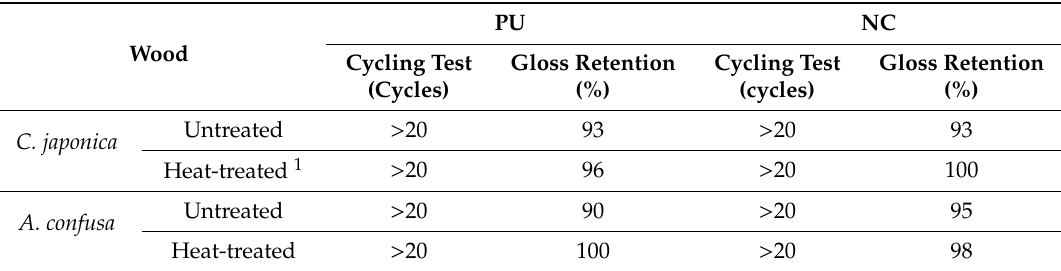
Table 3. Cycling test and gloss retention of untreated and heat-treated Japanese cedar ( Cryptomeria japonica ) and Formosa acacia ( Acacia confusa ) wood finished with polyurethane (PU) and nitrocellulose lacquer (NC)